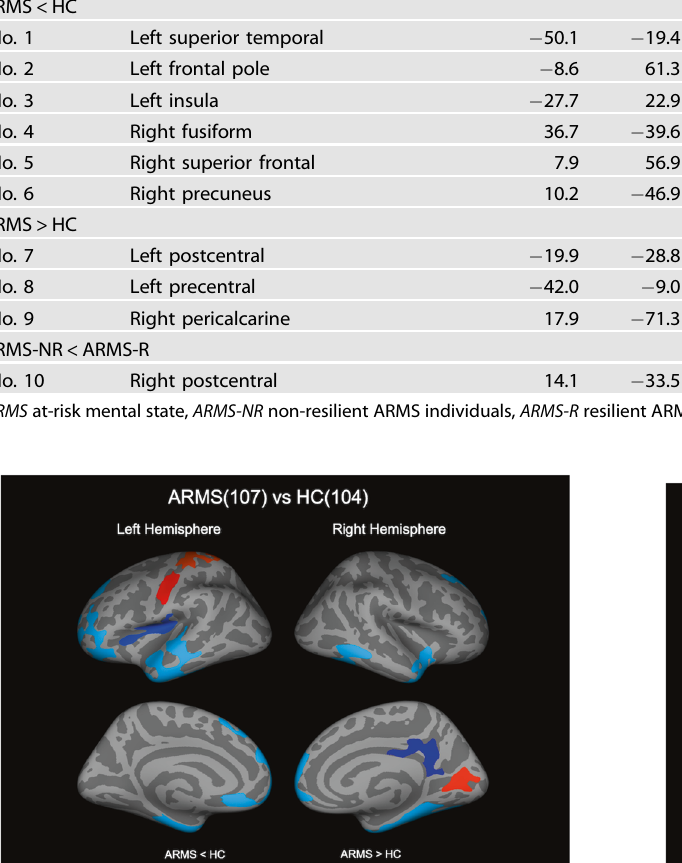
They also exhibited a signi fi cantly increased CT in the left pre- and postcentral gyri, right lingual gyrus, and right pericalcarine cortex (Fig. 1 and Table 2). There were no signi fi cant differences in CT between the ARMS individuals who later developed psychosis (ARMS-P) and those who did not (ARMS-NP) at baseline. The ARMS-NR group exhibited a signi fi cantly reduced CT in the right paracentral lobule compared with the ARMS-R group (Fig. 2 and Table 2). This cluster remained signi fi cant even when we strictly de fi ned the ARMS-NR (baseline GAF score > follow-up score and follow-up score < 65, n = 12) and ARMS-R (baseline score ≤ follow-up score and follow-up score ≥ 65, n = 31) sub-